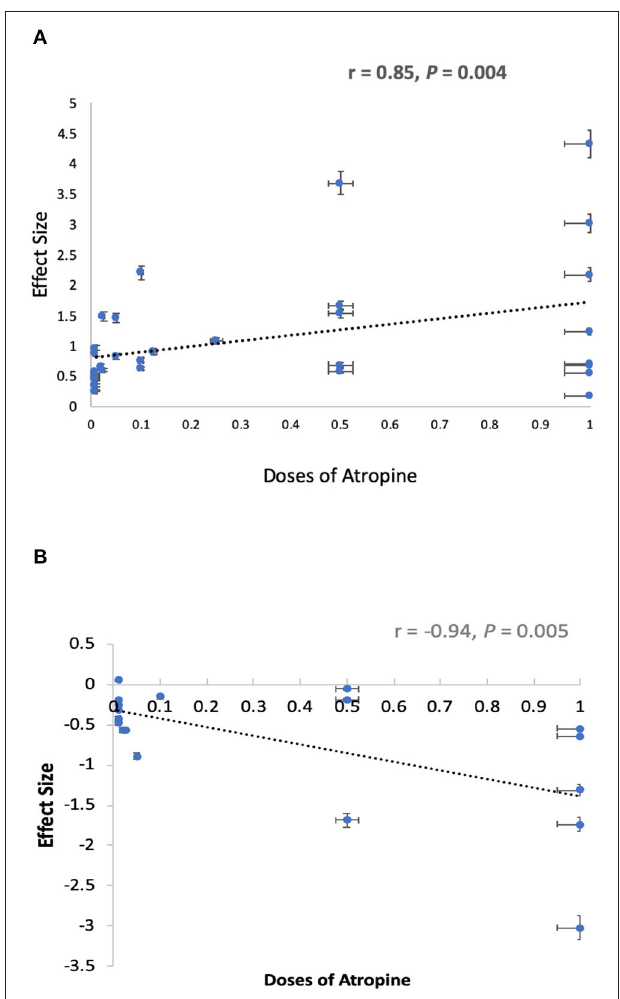
FIGURE 3 | Graphical summary of effect sizes of different doses of atropine for prevention of myopia progression. (A) Effect sizes of different doses of atropine for prevention of refraction change. (B) Effect sizes of different doses of atropine for prevention of axial elongation.